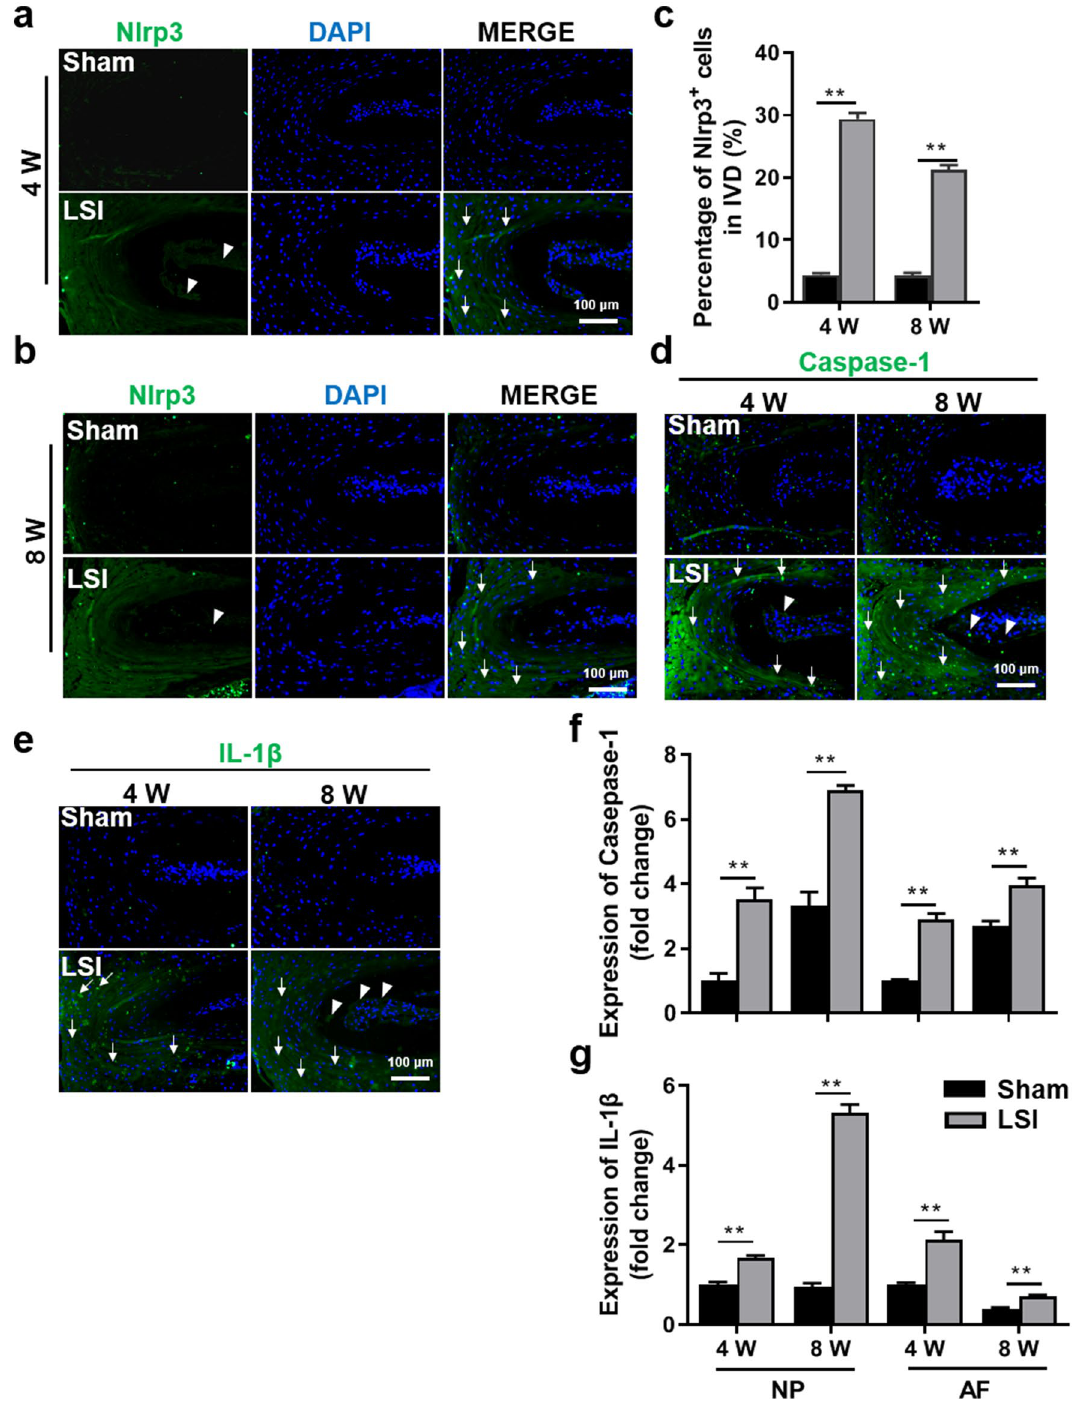
Figure 5. Aberrant mechanical stress-induced pyroptosis in IVD tissues. ( a , b ) Immunofluorescence staining for Nlrp3 expression (green) at 4- and 8-W post-surgery. DAPI stains nuclei blue. White arrowheads indicate high expression of Nlrp3 in NP; White arrows indicate high expression of Nlrp3 in AF. ( c ) Quantification of Nlrp3-positive cells in IVD of ( a , b ). ( d , e ) Immunofluorescence for Caspase-1 ( d ) and IL-1β ( e ) in the IVD (green) at 4- and 8-W post-surgery. DAPI stains nuclei blue. White arrowheads indicate a high expression of Caspase-1 in NP. White arrows indicate a high expression of Caspase-1 and IL-1β in AF. ( f , g ) Quantification of Caspase-1 and IL-1β expression in NP or AF region of ( d , e ). The averages of integrated optical density in interest region was calculated by Image-Pro Plus software version 6.0 (https ://www.media cy.com). Data are shown as mean ± sem. Three independent experiments were performed in triplicate. * P < 0.05, ** P < 0.01 compared to Sham